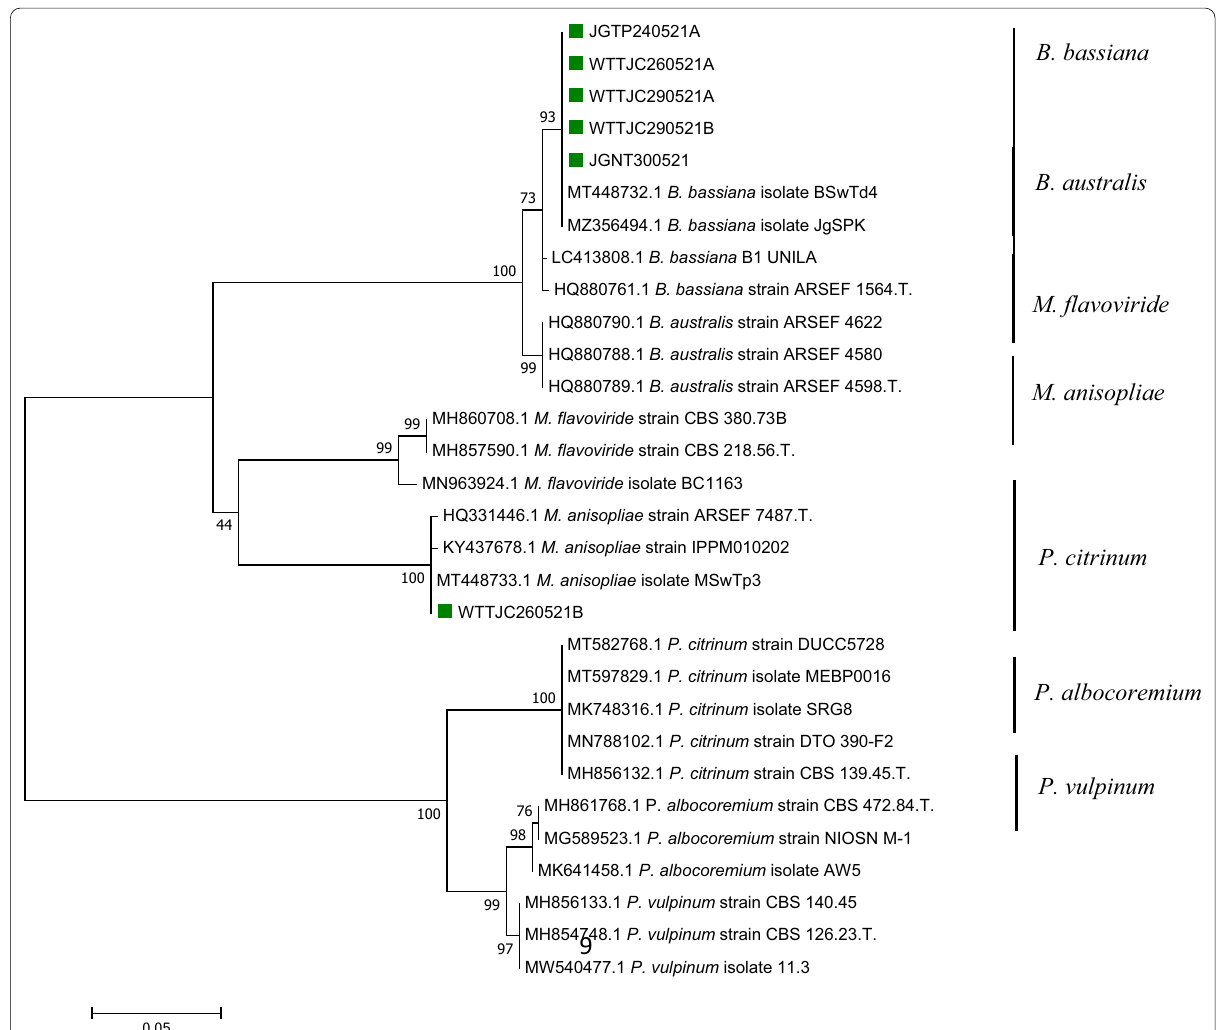
Fig. 2 Phylogenetic tree developed based on internal transcribed spacer (ITS) region by maximum likelihood (Tamura–Nei model). The six investigated isolates were placed within group of Beauveria bassiana (5 isolates) and Metarhizium anisopliae (1 isolate). T